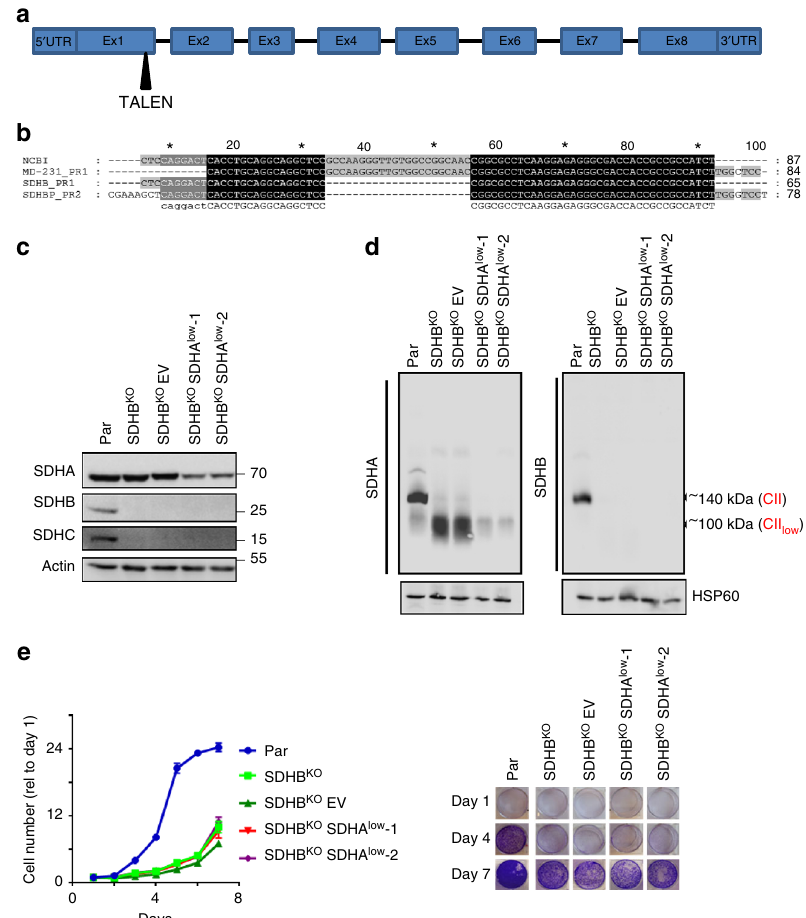
Fig. 2 SDHB depletion stabilizes CII low . a A scheme showing the structure of the SDHB gene and exon1 as the TALEN target. b DNA sequence alignment of the SDHB exon 1 from the GenBank nucleotide sequence database, and parental and SDHB KO MDA231 cells. Sanger sequencing was done from the PCR product ampli fi ed using two pairs of primers (PR1 and PR2) using genomic DNA as a template. c WB after SDS-PAGE of CII subunits in individual sublines, as shown. SDHB KO EV cells are SDHB KO cells transfected with empty vector and were used as a control for stable shRNA transfections. d NBGE of mitochondria isolated from parental, SDHB KO , SDHB KO EV, and SDHB KO SDHA low cells showing three variants of SDHA, using anti-SDHA IgG and anti- SDHB IgG. e Proliferation of MDA231 subline was analyzed at the indicated time points using the crystal violet method. Panel on the right shows crystal violet staining at 1, 4, and 7 days. Data are normalized to day 1. Data shown are mean values ± SD ( n = 3); images are representative of three